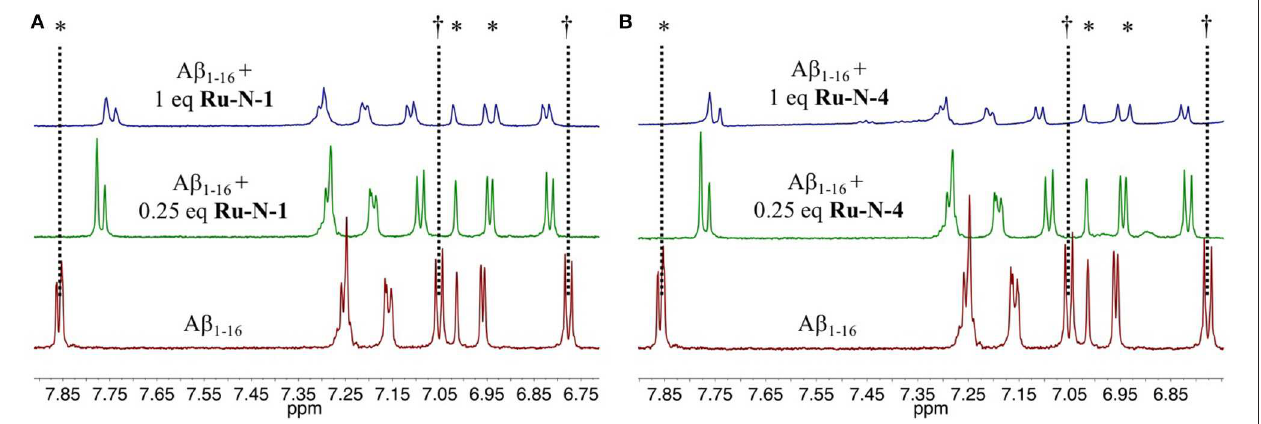
FIGURE 1 | Changes in the 1 H NMR spectra of A β 1 − 16 in the presence of Ru-N derivatives. Shown are spectra obtained from 205 µ M A β 1 − 16 , in pH 7.4 PBS/D 2 O buffer at 25 ◦ C (red) with addition of 0.25 eq. (green) and 1 eq (blue) of (A) Ru-N-1 or (B) Ru-N-4 . *His 6 , His 13 and His 14 . † Tyr 10